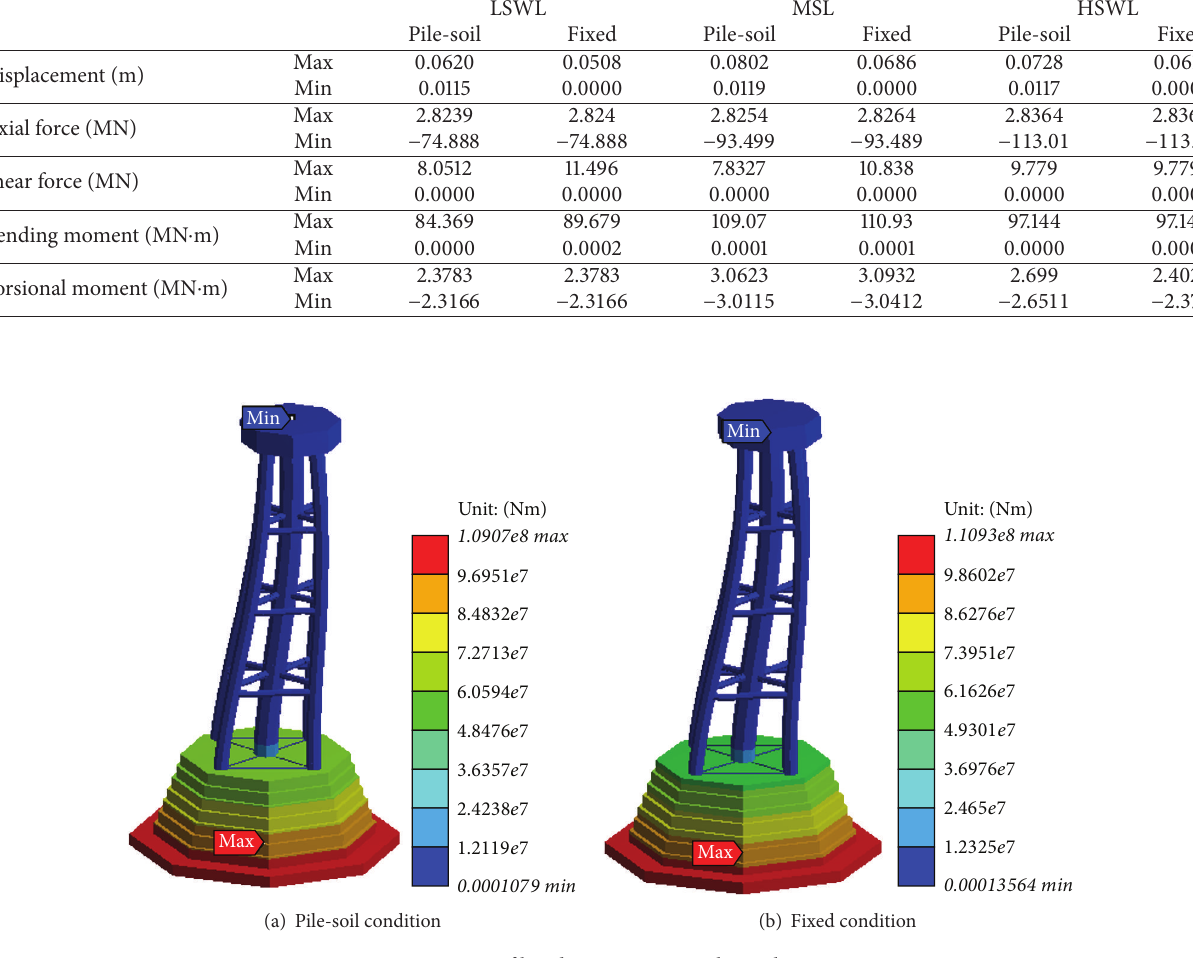
Figure 10: Comparison of bending moments with regular wave at